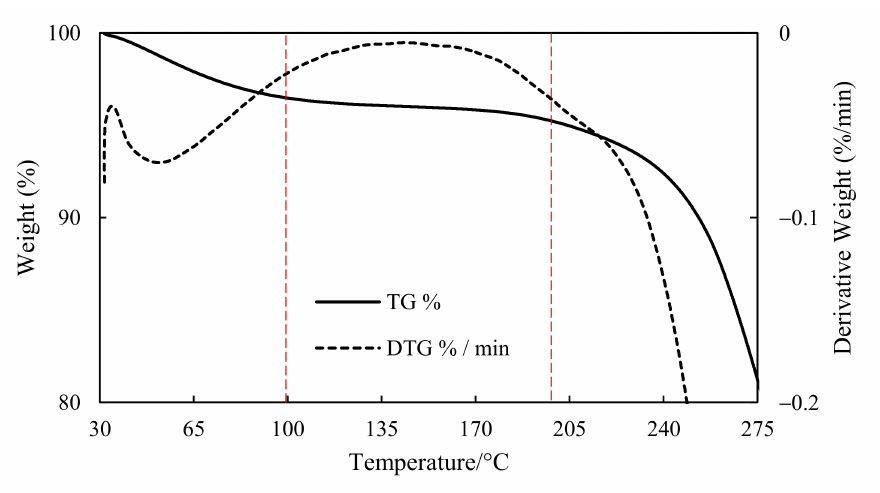
Figure 2. TGA test results of Moso bamboo to determine heating range.